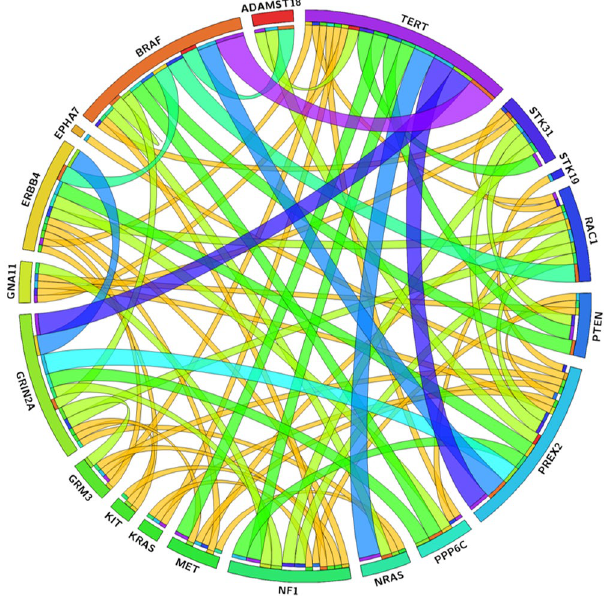
Figure 3. Circos diagram. Associations between the more prevalent genes.